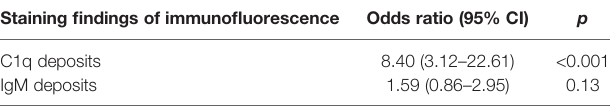
TABLE 5 | Logistic regression analysis for glomerular C3 deposits according to the data of C1q and IgM deposits. Staining fi ndings of immuno fl uorescence